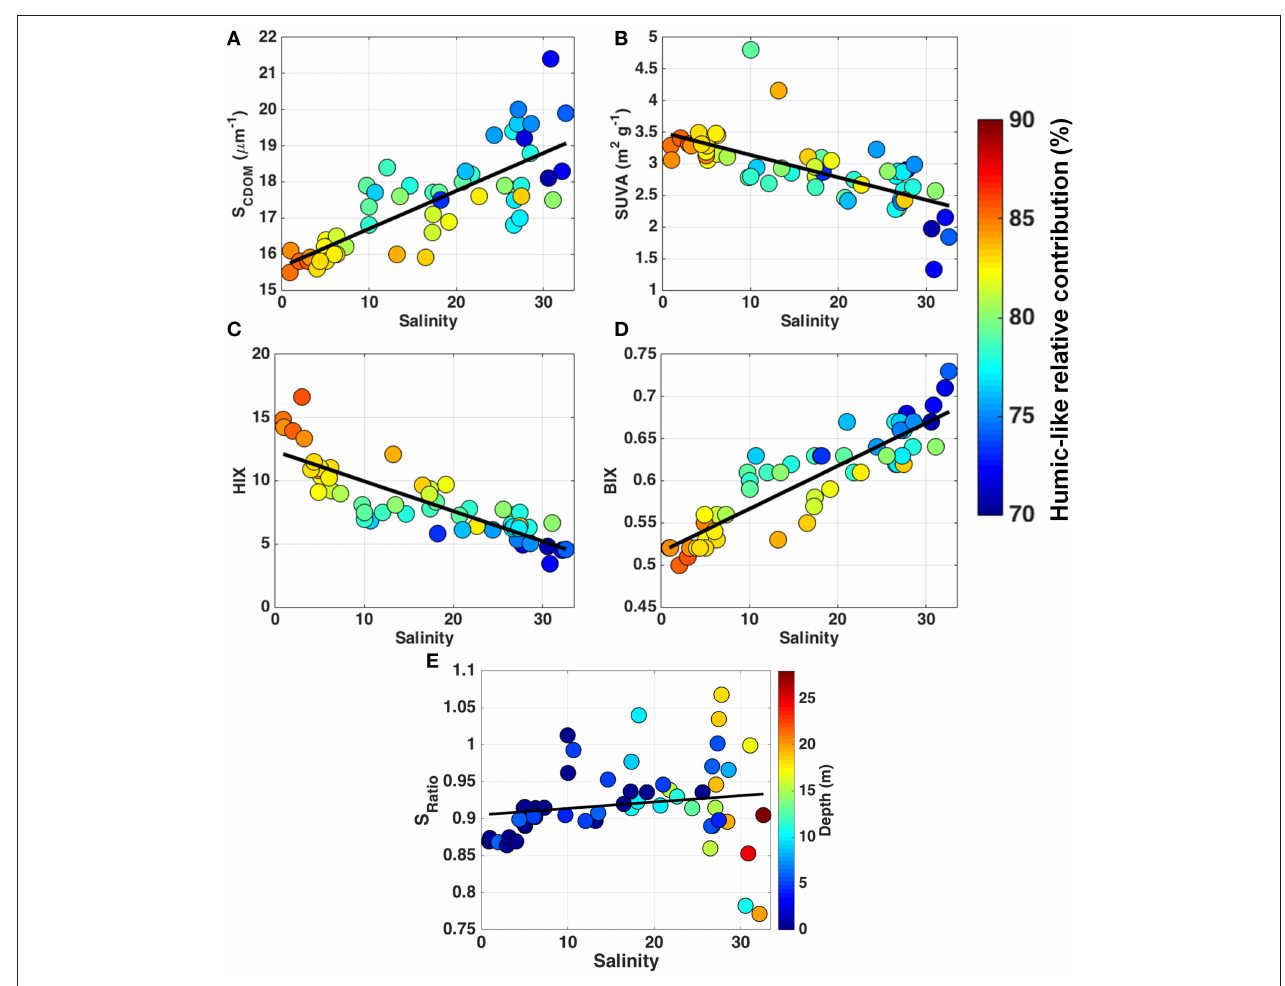
FIGURE 5 | The relationship between the optical indices of DOM modification and salinity for all the samples: S CDOM ( µ m − 1 ) (A); SUVA (m 2 g − 1 ) (B); HIX (C); BIX (D); Slope ratio (E). Colorbar indicates the relative contribution (%) of the humic-like signal (C1 + C2 + C4 + C5) to the total FDOM (A–D) and depth (m; E ). Black lines indicate the regression lines between each parameter and